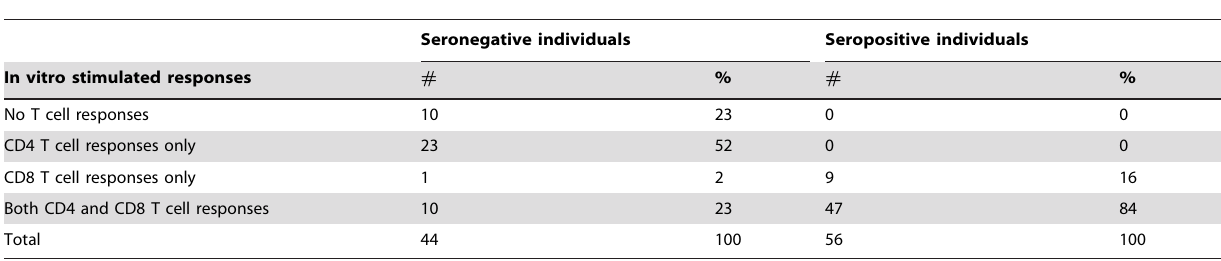
Table 2. In vitro stimulated responses.